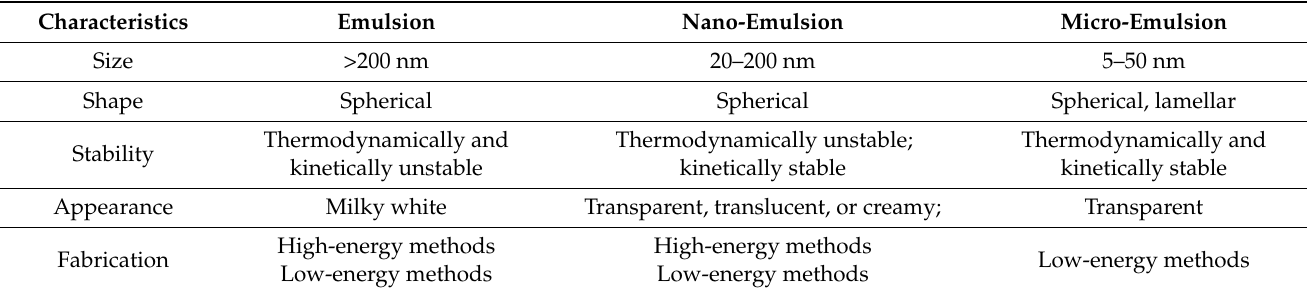
Table 2. Comparison of macro-, nano- and